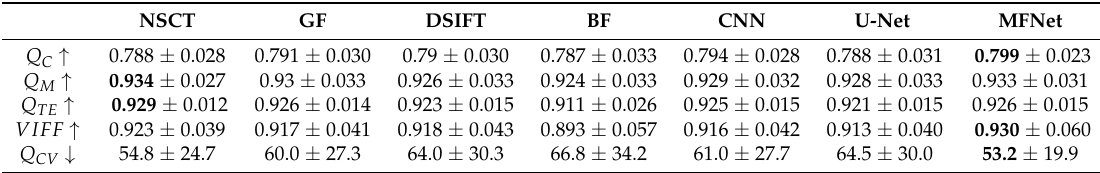
Figure 10. Fused results of nine pairs of source images obtained by different fusion methods. Table 1. Comparison of the mean and standard deviation ( ± SD) of five evaluation metrics between the unsupervised MFNet and the state-of-the-art supervised